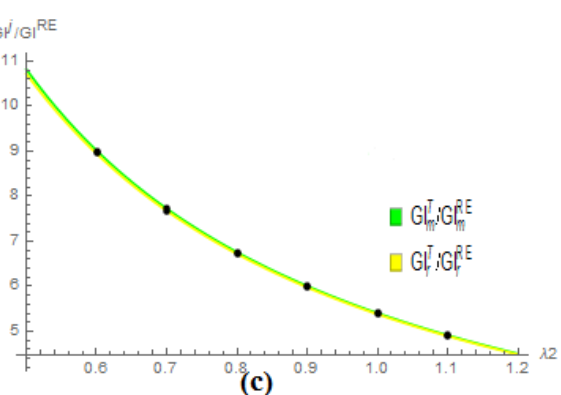
Figure 5. ( a ) Ratio greening levels in different subsidy policies. ( b ) Ratios of amount of government subsidy in Policy C and RE. ( c ) Ratios of amount of government subsidy in Policy T and